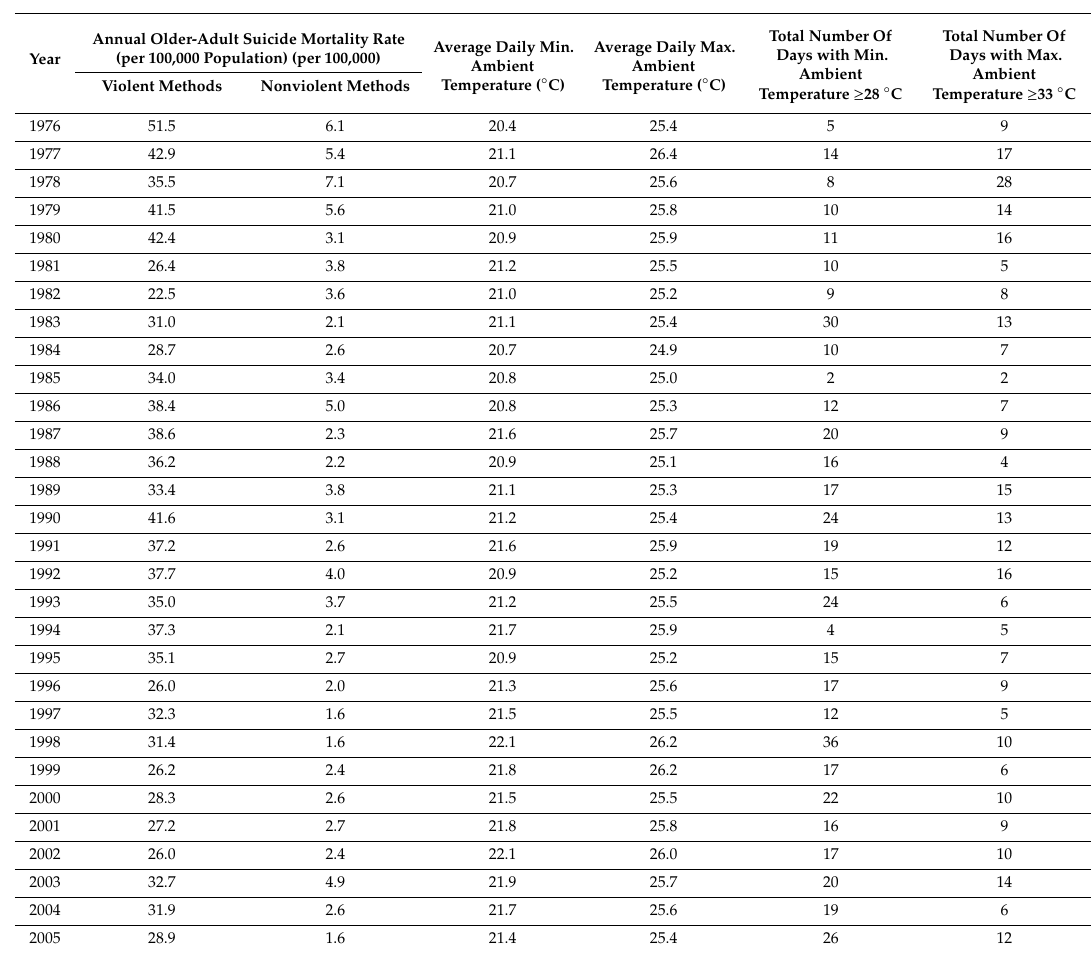
Table A2. Summary of key data used in the